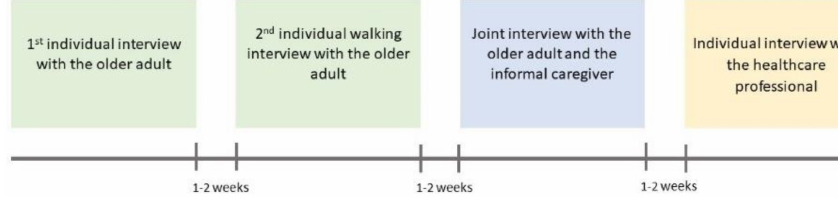
Figure 1. Data collection phases.